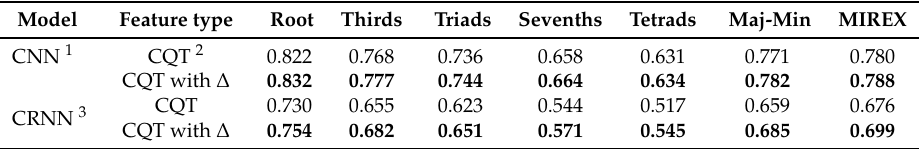
Table 4. Weighted Chord Symbol Recall (WCSR) Scores of the Compared Methods. The Best Values are Represented in Bold. ( ∆ represents delta and delta-delta).